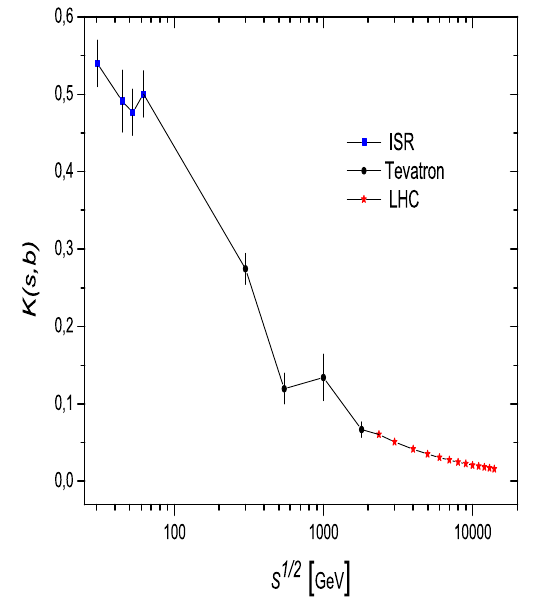
Fig. 11 Inelasticities calculated at b ≈ 0 as a function of the center of mass energy, Eq. (28). The results show marked decrease in the inelasticity from ISR to LHC energies. The error bars represent